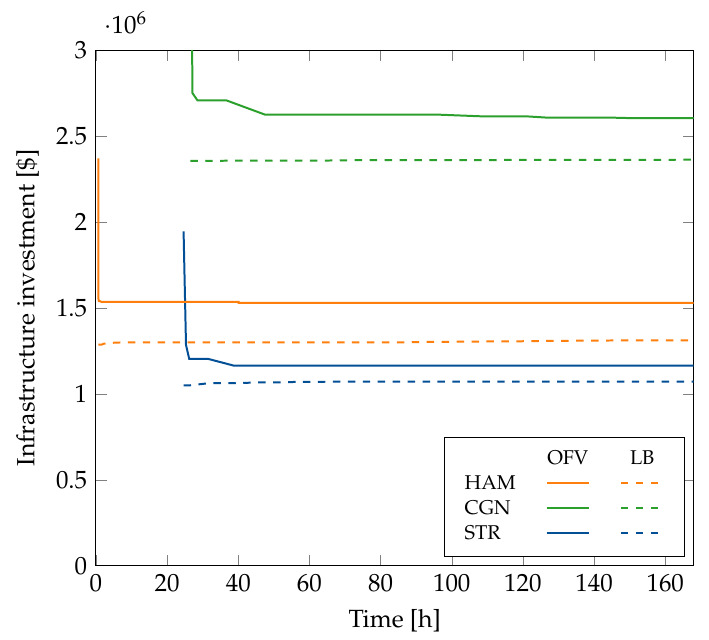
Figure 7. Solution process in the large instances. Table 5. Analysis of simplifications in the large instances (Time limit: